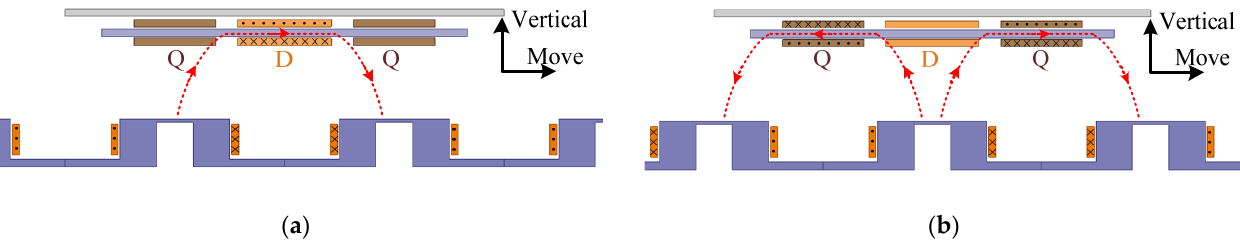
Figure 2. Two modes of the dual-phase NSP receiver along move direction: ( a ) Mode 1; ( b ) Mode 2.